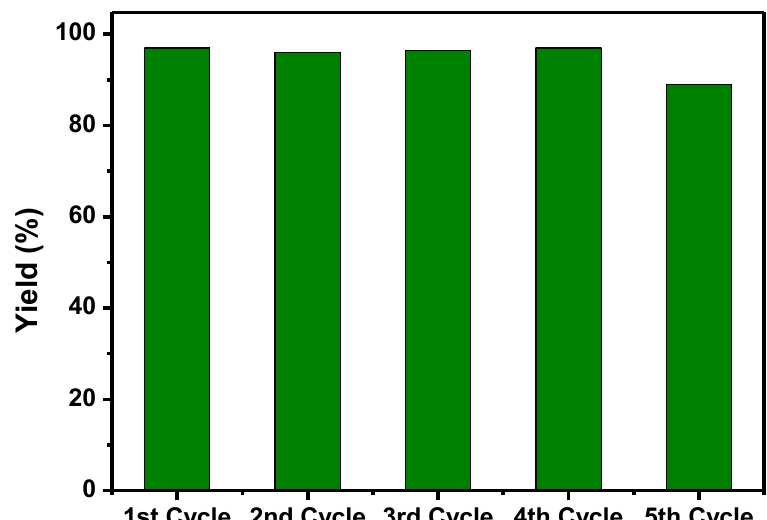
Figure 10. The recycle experiment over 5Cu(0)-AAPTMS@RGO-MCM-41 catalyst.